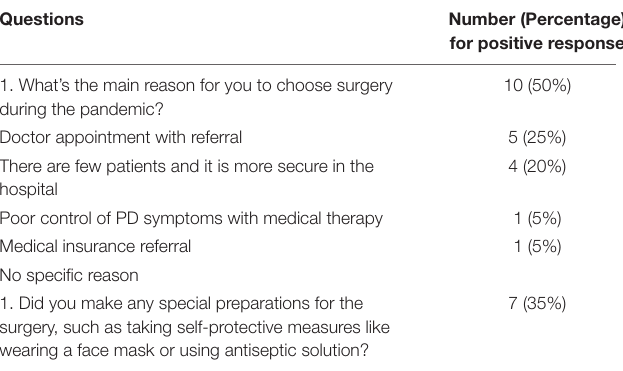
TABLE 3 | Reasons for seeking deep brain stimulation surgery.